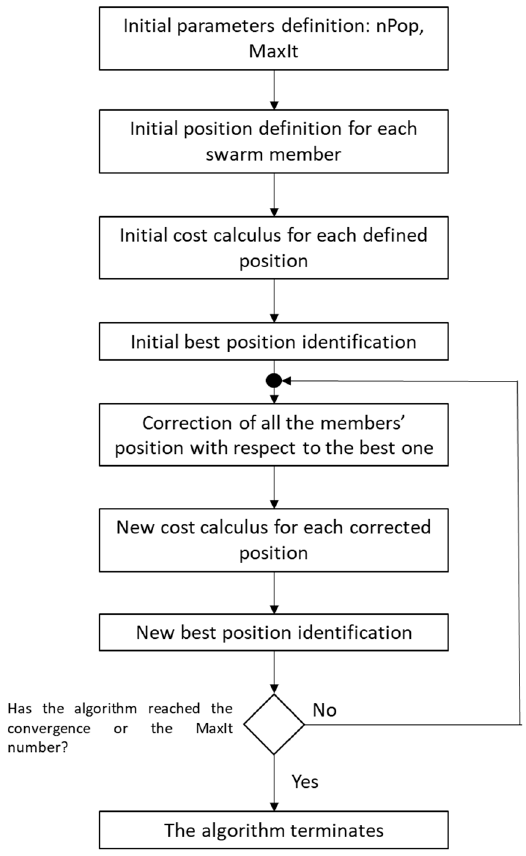
Figure 8. The General Swarm Intelligence algorithm scheme. The user defines the swarm population size (nPop) and the maximum iterations number (MaxIt) at the initial step. At this point, for each swarm member, an initial posi- tion and its relative positional cost are defined according to a specific function decided by the user. In this paper, the Root Mean Squared Error was chosen since it describes the data concentration around the best fit line. The position with the minimum cost value is assumed to be the temporary best solu- tion. The iterative phase starts until the maximum number of iterations is reached, or the error between the solutions of two consecutive iterations is equal to a fixed threshold. According to the specific SI algorithm adopted, each position is corrected with respect to the best one during this phase. Specifically, it is possible to refer to Table 3 to analyze how each algorithm defines the new position for each swarm member. Table 3. References for a detailed study. Algorithm